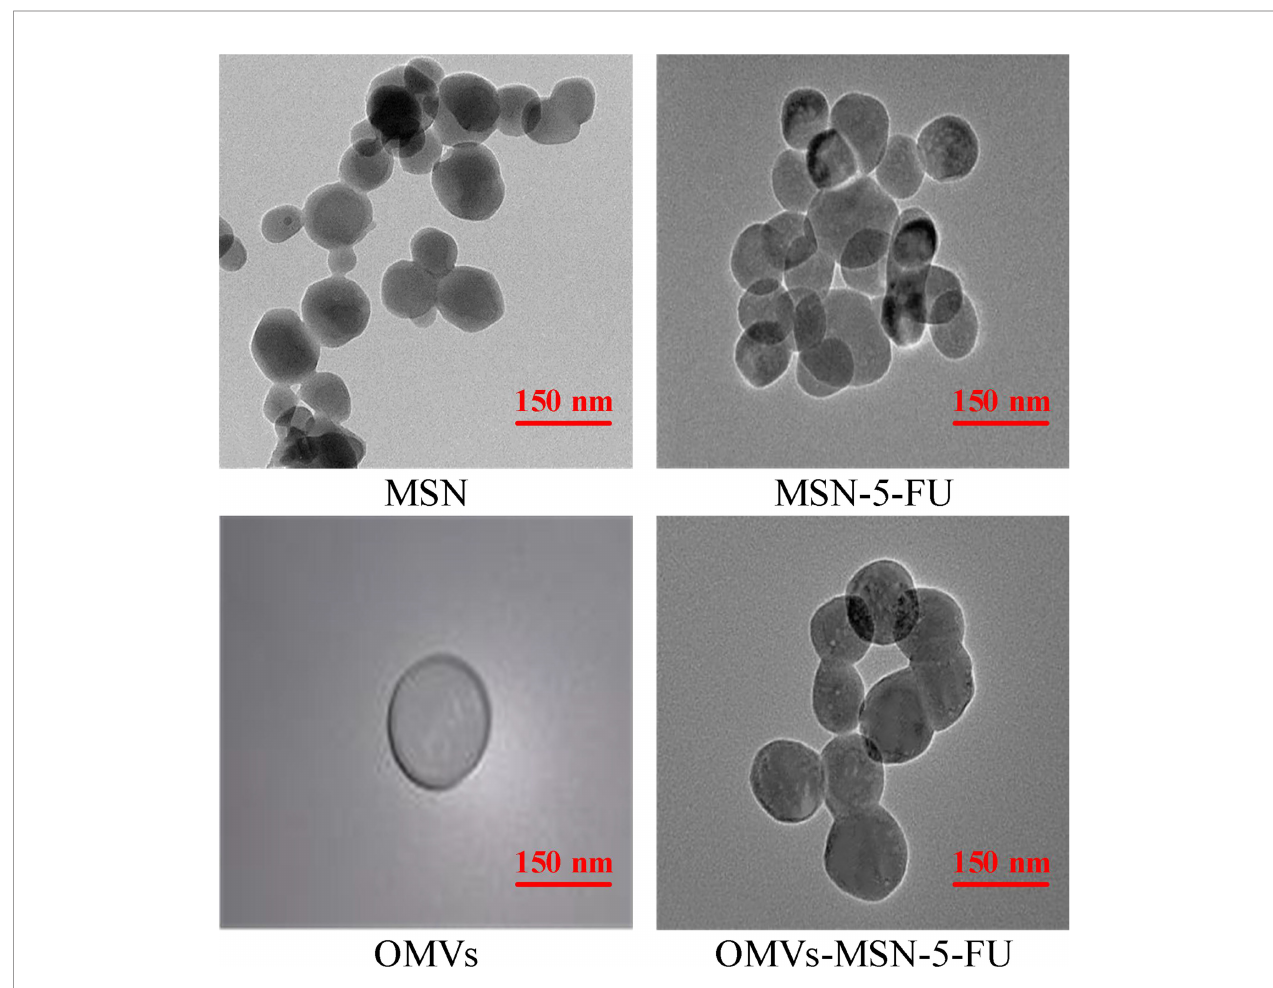
FIGURE 4 | Transmission electron microscope